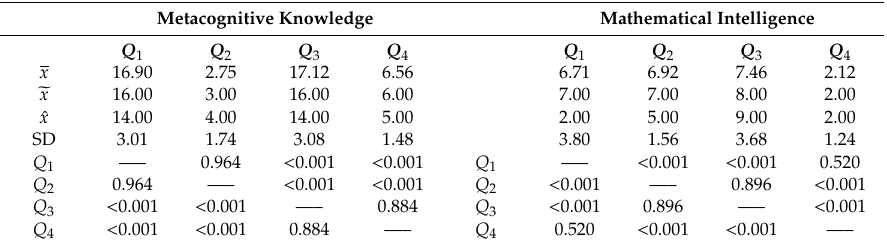
Table 3. Di ff erences between the levels of metacognitive knowledge and mathematical intelligence achieved by respondents in the estimated